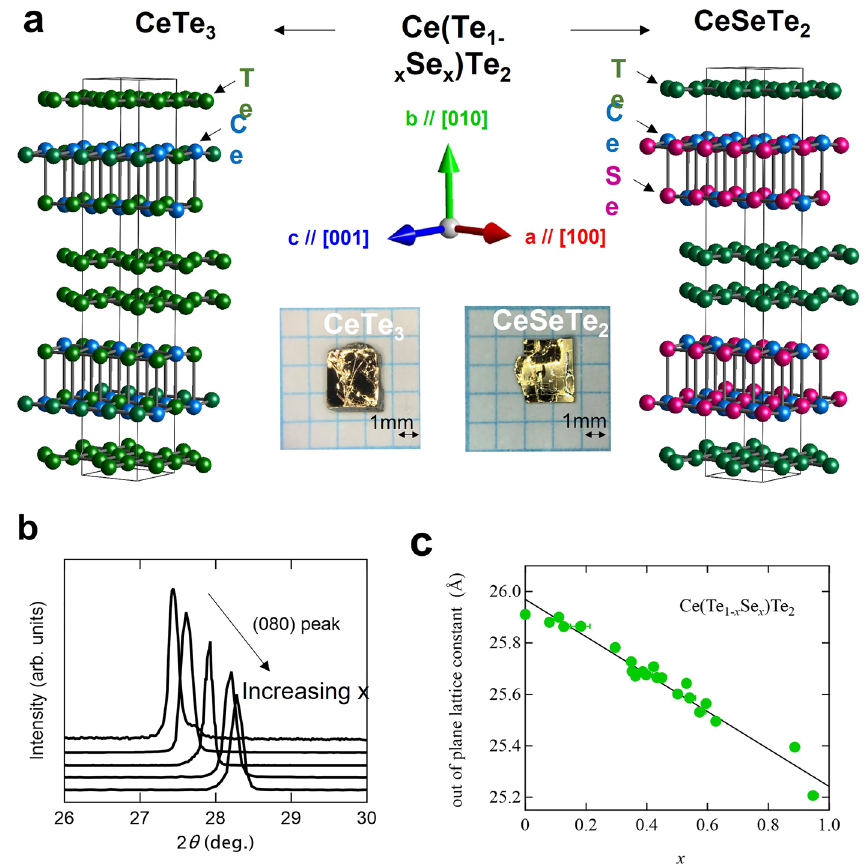
Figure 1. Systematic change of chemical pressure by iso-valent elemental substitution in a vdW coupled material Ce(Se x Te 1− x )Te 2 . ( a ) Crystal structures of CeTe 3 (left) and CeSeTe 2 (right). Substituted Se atoms enter the magnetic blocking layer selectively. The typical picture of single crystals and the definition of crystallographic directions are also shown. ( b ) Doping dependence of characteristic X-ray diffraction (XRD) patterns near the (0 8 0) peak for Ce(Se x Te 1− x )Te 2 . ( c ) The out of plane lattice constant b as a function of doping x determined from energy dispersive X-ray spectrometry (EDX). This relation was obtained by performing both XRD and EDX on individual crystal